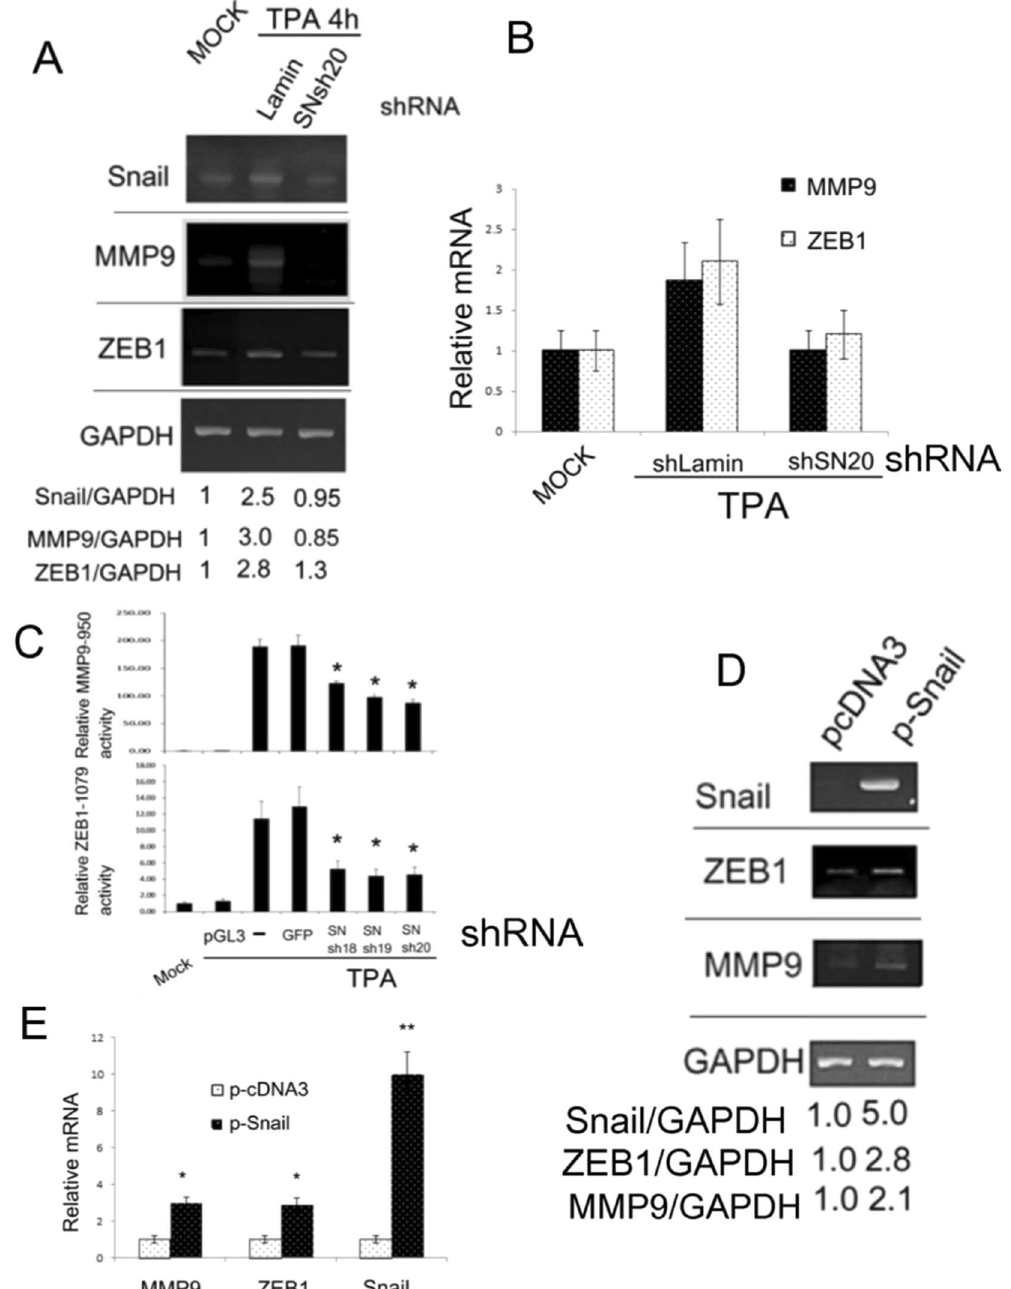
Figure 1. Snail is essential for expression and promoter activation of MMP9 and ZEB1. HepG2 cells were transfected with none (MOCK) or plasmids encoding indicated Snail shRNAs ( A , B , C ) and control shRNA of Lamin ( A ), ( B ) or GFP ( C ) for 24 h followed by untreated (MOCK) or treated with 50 nM TPA for 4 h ( A ); 4 and 6 h for ZEB1 and MMP9, respectively ( B ); or 12 h ( C ). HCC340 were transfected with pcDNA3 vector or Snail expressing plasmid (p-Snail) for 36 h ( D ) and ( E ). RT-PCR ( A ), ( D ) and quantitative RT-PCR ( B ), ( E ) of Snail, MMP9 and ZEB1 and promoter assay of MMP9-950 (C, upper panel) and ZEB1-1079 (C, lower panel) were performed. In ( A , D ), the numbers below each figure are the ratios of relative mRNA based on RT-PCR of indicated transcriptional factor vs GAPDH, taking the data of MOCK ( A ) and pcDNA3 ( D ) as 1.0. The results are average of 3 reproducible experiments with C.V. of 7.5%. In ( B ) and ( E ), the relative mRNA was calculated based on real time RT-PCR, taking the data of MOCK ( B ) and pcDNA3 ( E ) as 1.0. In ( C) , the relative dual luciferase activity of MMP9-950 or ZEB1-1079 was calculated, taking MOCK as 1.0. The data in ( B ), is average of two representative experiment with C.V. of 12%. In ( C ) and ( E ), ( ** , * ) represent the statistically significant difference (p < 0.005, N = 3), (p < 0.05, N = 3) between the indicated samples and the control GFP shRNA ( C ) and pcDNA3 ( E )